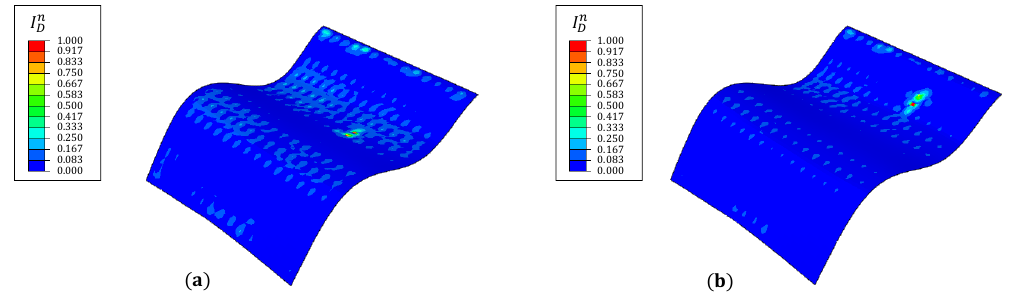
Figure 11. The damage index contour plots of mode 8 for damage case ( a ) 1 and ( b )